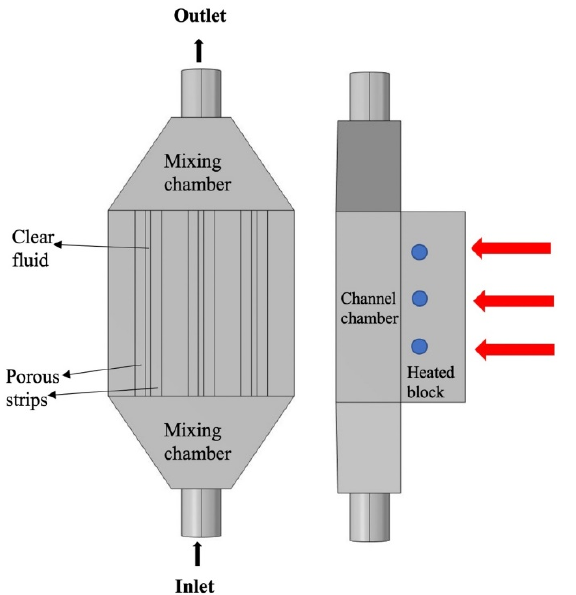
Figure 1. Problem description.